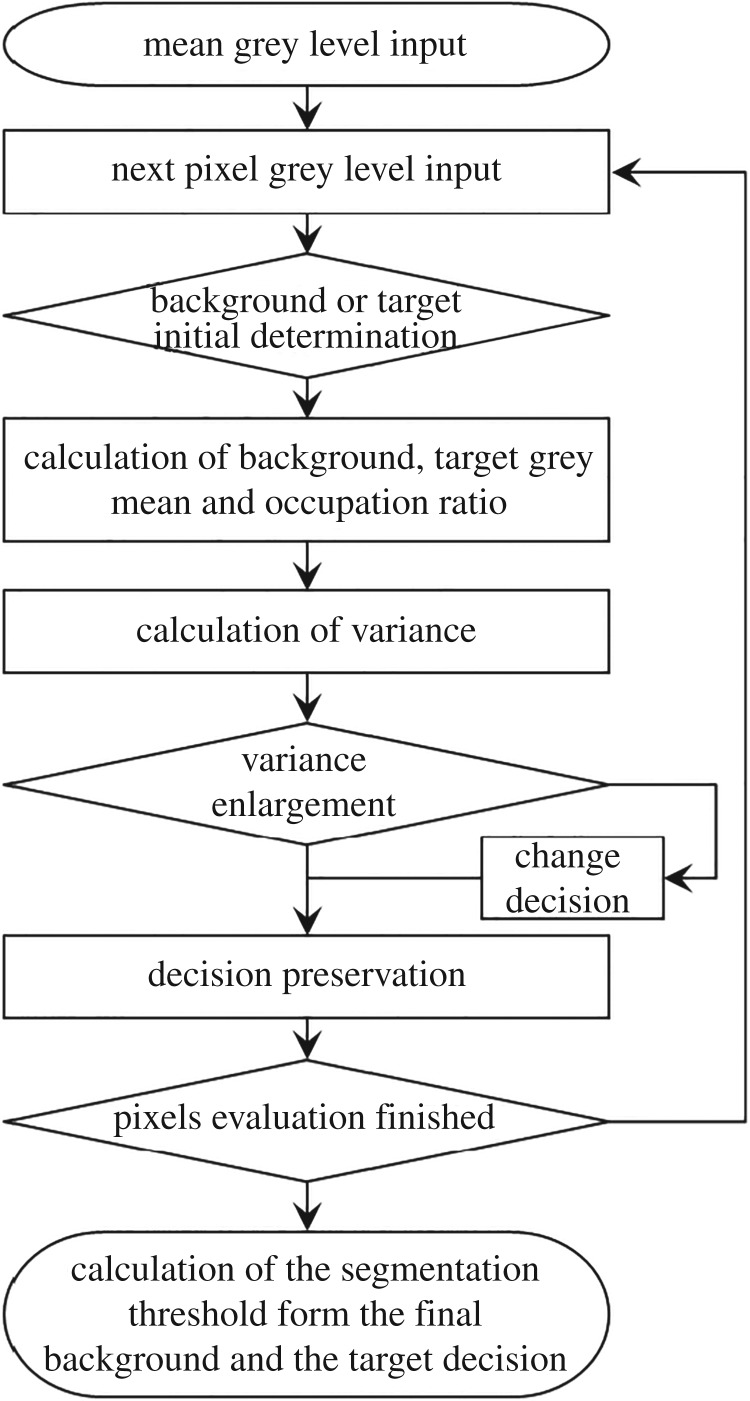
The process for calculating the grey threshold of OTSU.